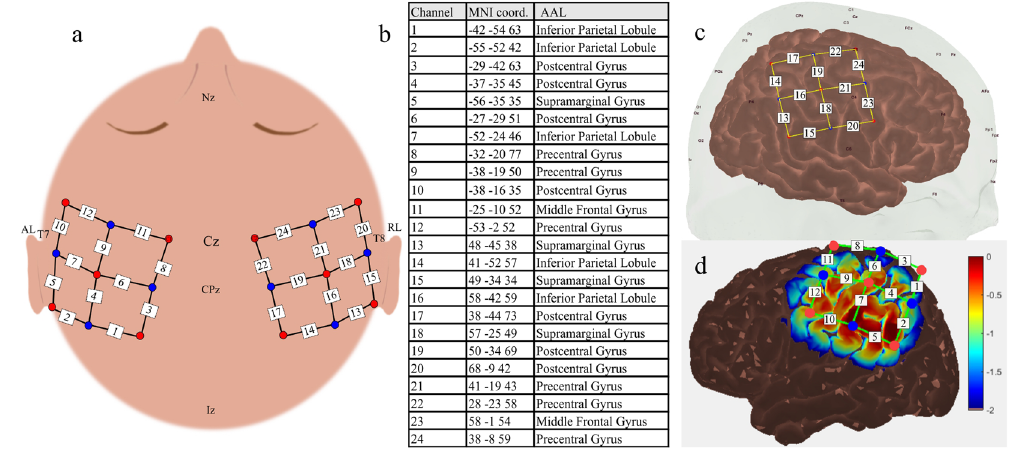
Figure 7. fNIRS measurement setup. ( a ) Probe arrangement and corresponding channels (1–24) as referenced to international 10/10 positions. Red: Sources; Blue: Detectors; White numbered boxes: Channels. ( b ) Channel projections onto underlying structures performed in AtlasViewer resulting in coordinates in standard MNI space and corresponding brain labels (Automated Anatomical Labeling, AAL). ( c) Probe position planning in AtlasViwer software. ( d ) Sensitivity profile of the constructed probe setup as simulated in AtlasViewer using the built-in tMCimg software. Sensitivity is displayed on a logarithmic scale spanning two orders of magnitude (0 to − 2) in arbitrary units with values around ‘0’ represent high sensitivity of the channels to the underlying neural structures and more negative values represent a relatively decreasing